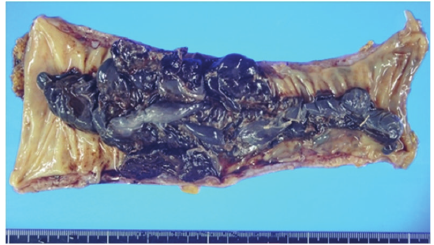
Figure 3: The huge submucosal hematoma in the sigmoid